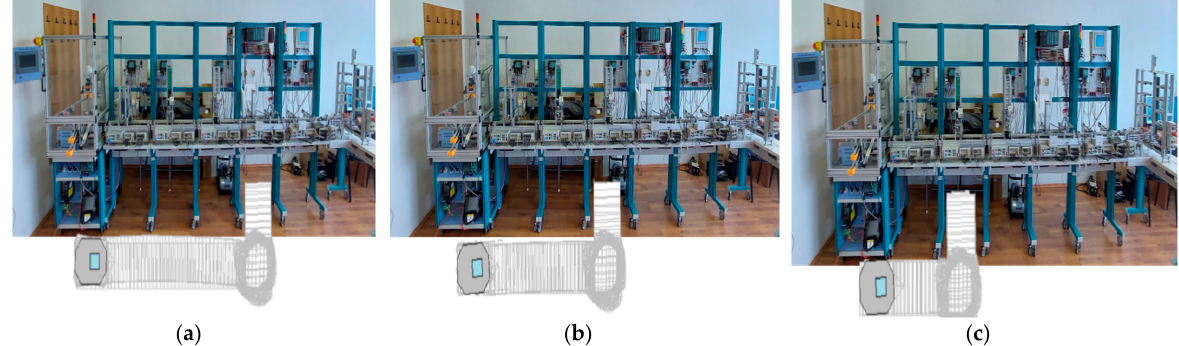
Figure 17. Forward and backward CAS’s trajectories to transport disassembled components to appropriate warehouses: ( a ) plastic cylinders, ( b ) cover, ( c ) body.